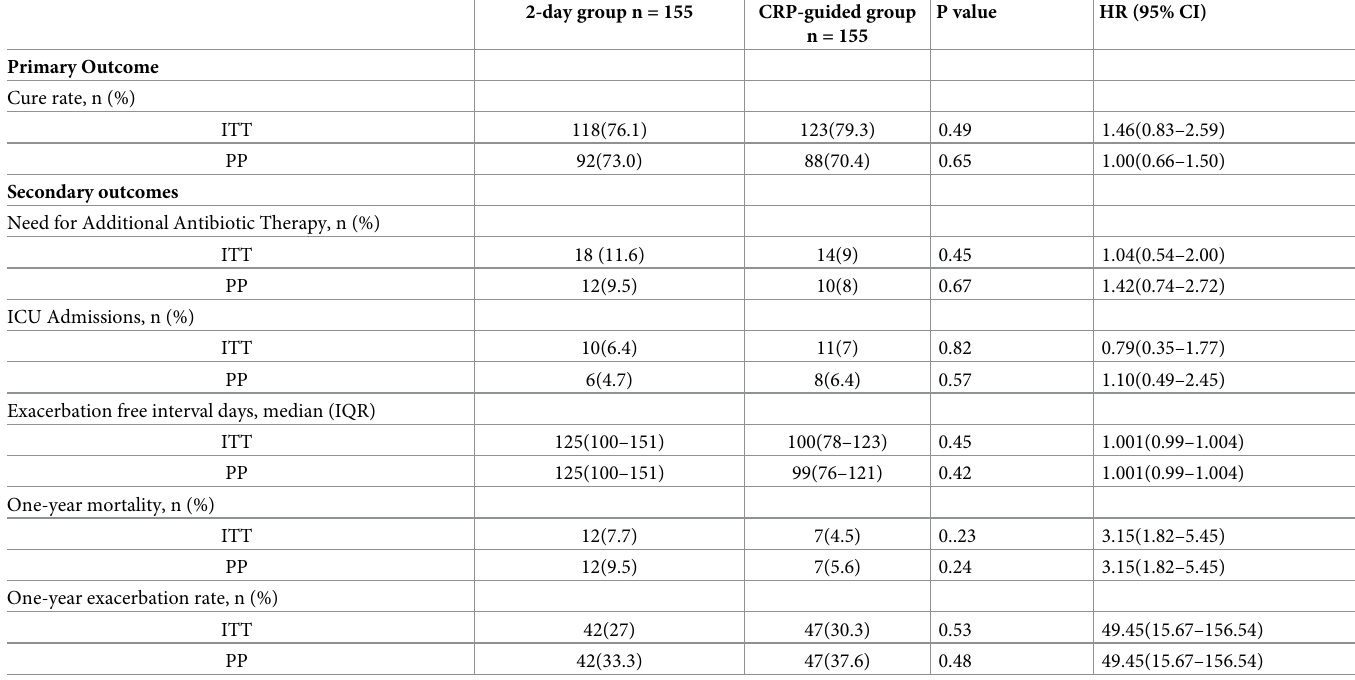
Table 3. Patients’